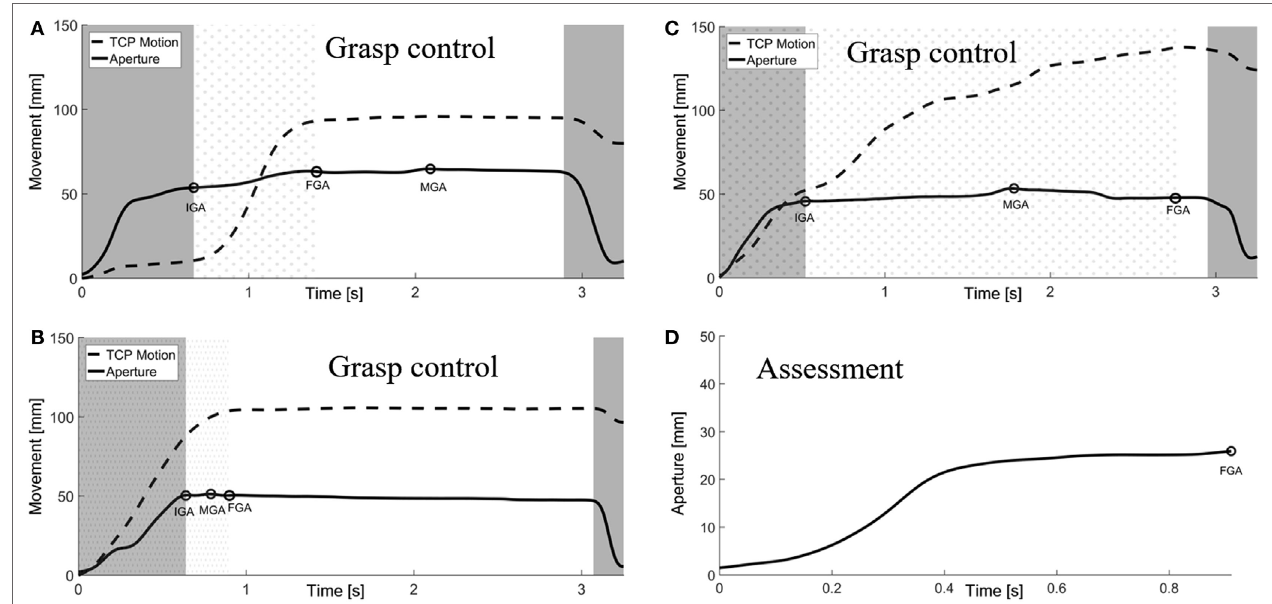
FigUre 3 | Perceptual assessment and grasp control: representative motion profiles for tool center point motion (TCP) toward the object (dotted line) and for the grip aperture (full line). (a) Grasp control, across, object L (Participant 1). (B) Grasp control, alongside, object L (Participant 2). (c) Grasp control, alongside, object XL (Participant 3). (D) Assessment, across, orientation object M (Participant 4). For grasp control movements gray background marks aperture opening and closing durations. Dotted background marks motion forward